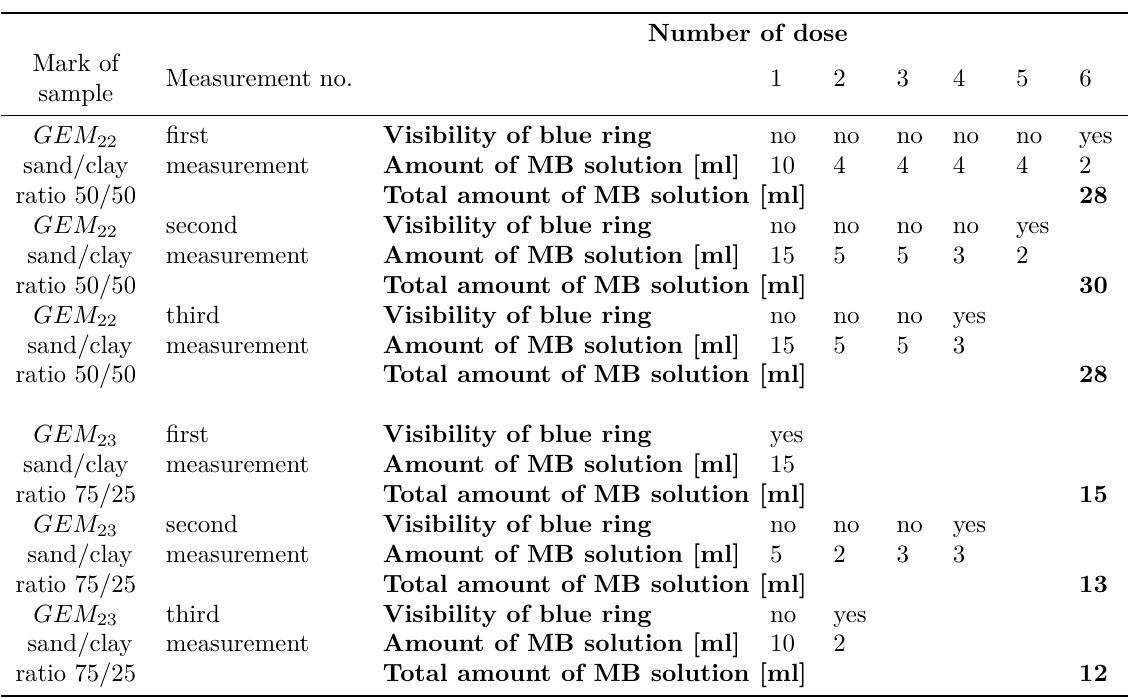
Table 4. Doses of methylene blue solution to GEM earth sample where stirring time shorter than 1 minute is used for each 1 ml of MB solution in earth samples .